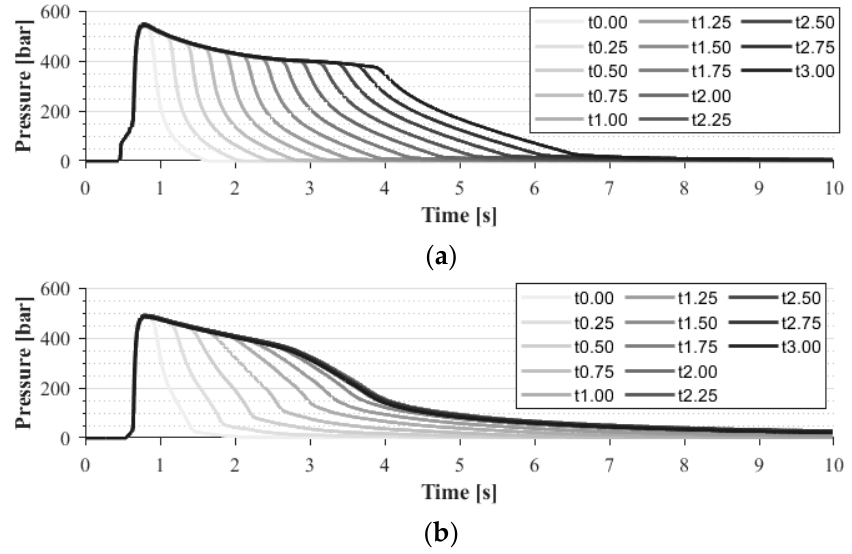
Figure 11. In-mold pressure curves as a function of time and holding time measured with a: ( a ) pre-gate sensor; ( b ) post-gate sensor (cavity 01).